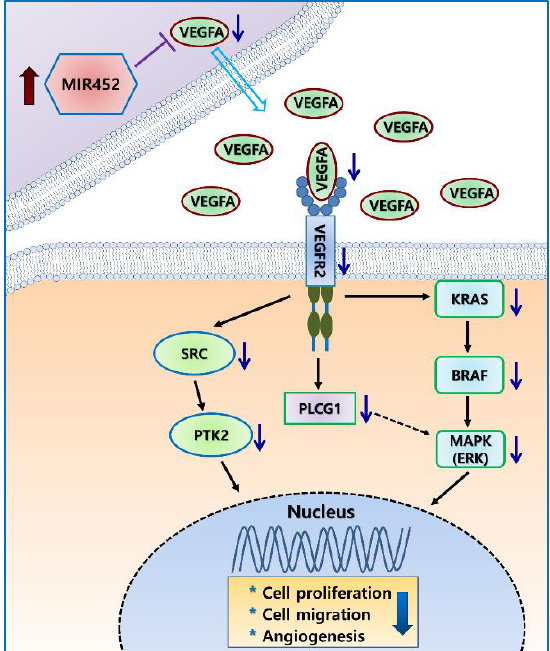
Figure 8. A simple putative mechanism of MIR452 regulation of VEGFA-induced cell proliferation, cell migration, and angiogenesis in human CRC. The increased MIR452 expression in CRC cells led to downregulation of cellular and extracellular VEGFA as well as VEGFR2 levels. The decreased VEGFR2 level caused inhibition of SRC, and, consequently, PTK2 was downregulated. In parallel, KRAS expression was inhibited by the downregulation of VEGFR2; this, in turn, caused inhibition of BRAF and MAPK3/1 (Extracellular signal – regulated kinase, ERK1/2) and led to the expression of growth-promoting genes. Consequently, the elevated MIR452 level in CRC led to inhibition of cell proliferation, cell migration, and angiogenesis. This simple hypothetical mechanism of MIR452-mediated inhibition of angiogenesis was based on the results of previous studies and our study presented herein.